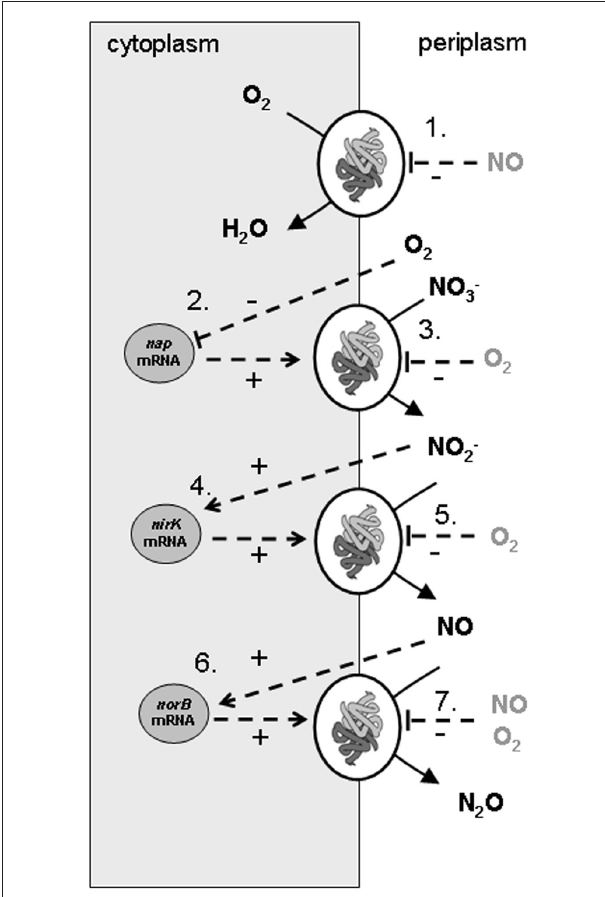
FIGURE 1 | Scheme of conversions and regulation of denitrification pathway in Agrobacterium tumefaciens as used in the metabolic model of the experiments. The combination of experimental data and the metabolic model led to identification of nirK and norB transcription activated by their substrates, nap transcription by oxygen limitation, apparent (indirect, via electron transport chain) oxygen inhibition of the denitrification conversions and NO inhibition on the cytochrome c oxidase. The processes that were modeled are: (1) oxygen reduction, (2) nitrate reductase synthesis, (3) nitrate reduction, (4) nitrite reductase synthesis, (5) nitrite reduction, (6) NO reductase synthesis, (7) NO